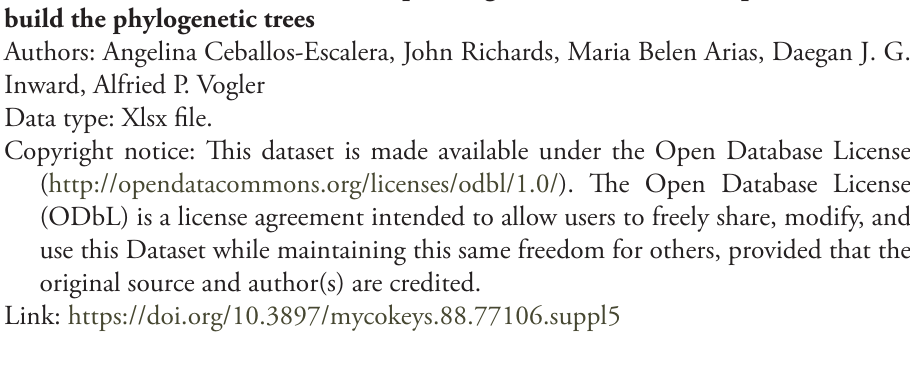
Table S1. Accession numbers corresponding with the reference sequences used to build the phylogenetic trees Authors: Angelina Ceballos-Escalera, John Richards, Maria Belen Arias, Daegan J. G.